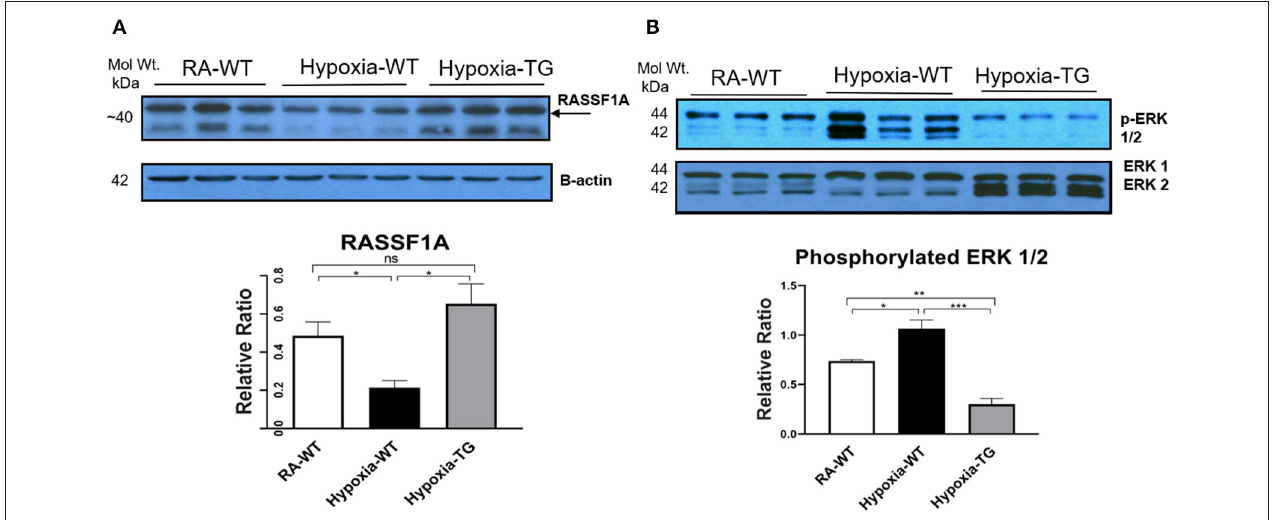
FIGURE 6 | Western blot analysis for RASSF1A and ERK1/2. Adult mice (C57B6) (WT) and EC-SOD transgenic mice (TG), were exposed to 10% hypoxia for 21 days (WT). Room air animals were used as control group (RA). WB analysis was used to assess protein levels of RASSF1A (A) and ERK1/2 (B) in the right ventricular tissue. All experiments were carried out in triplicate. Data represents mean ± SEM. * P < 0.05, ** P < 0.01, *** P < 0.001, **** P < 0.0001.